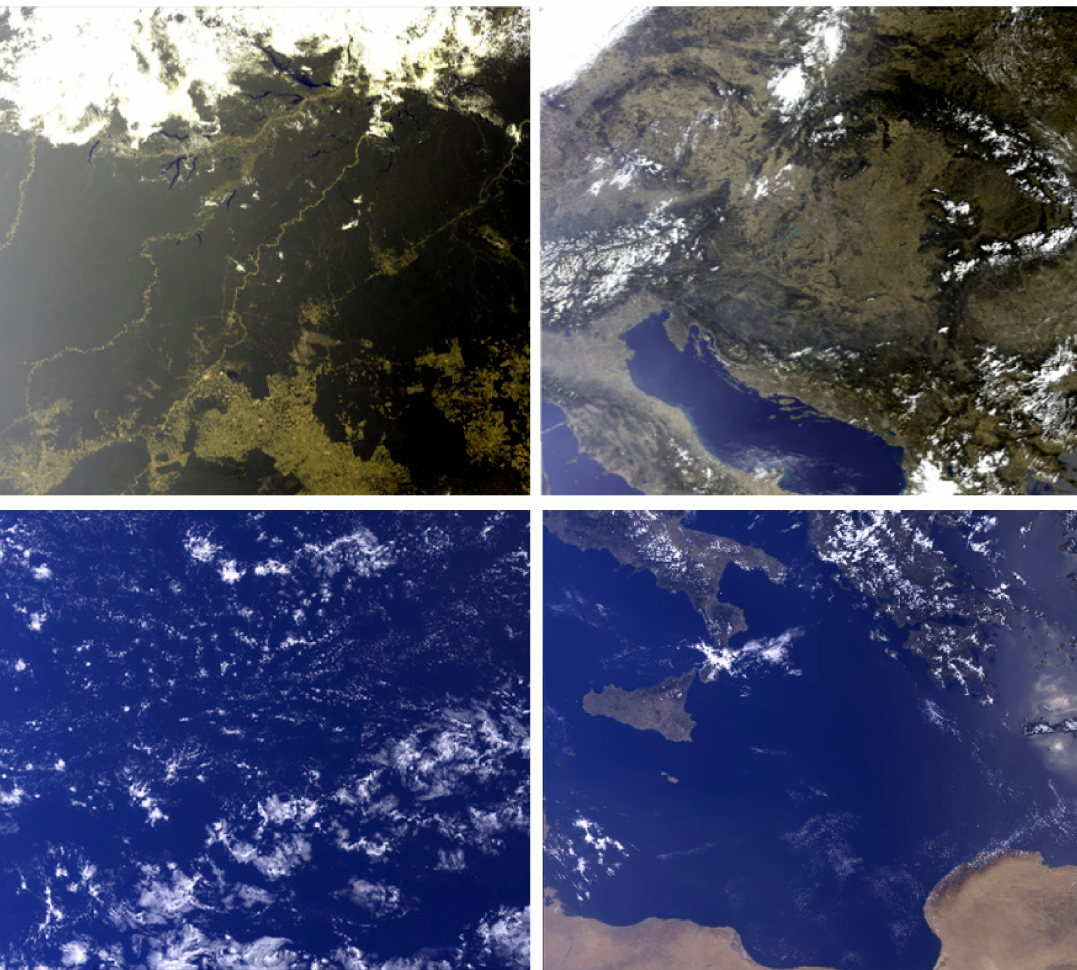
Figure 5. RGB images of the selected scenes for L2 full resolution comparisons: Amazonia and Europe (top) for the land branch, South Pacific Gyre and Mediterranean Sea (bottom) for the water